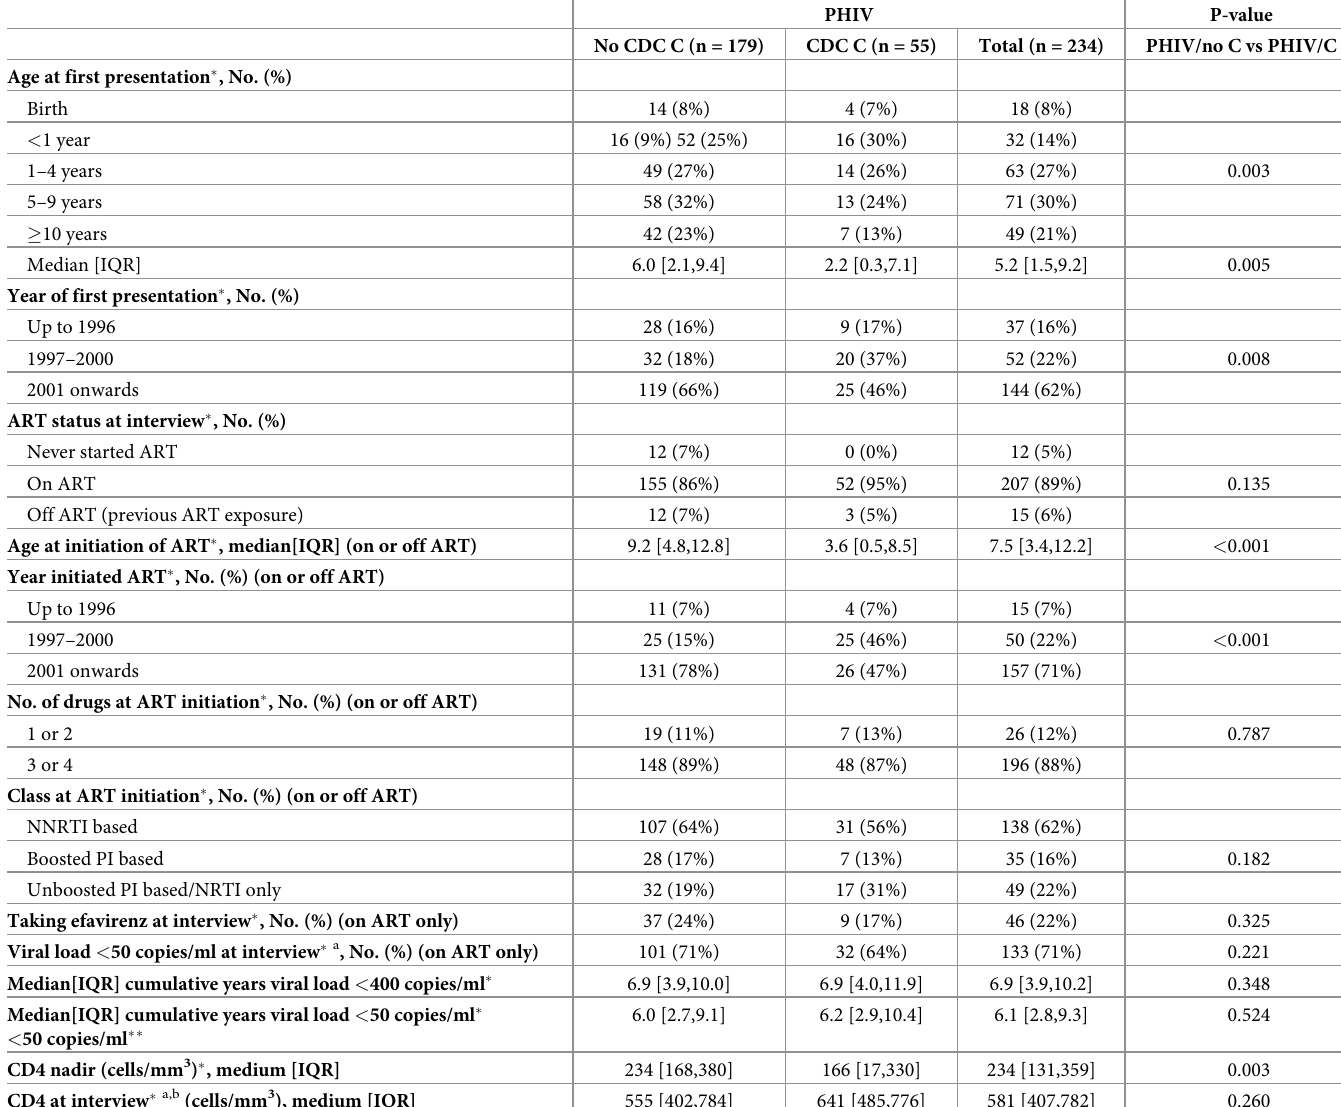
Table 2. HIV-related characteristics of PHIV participants by CDC